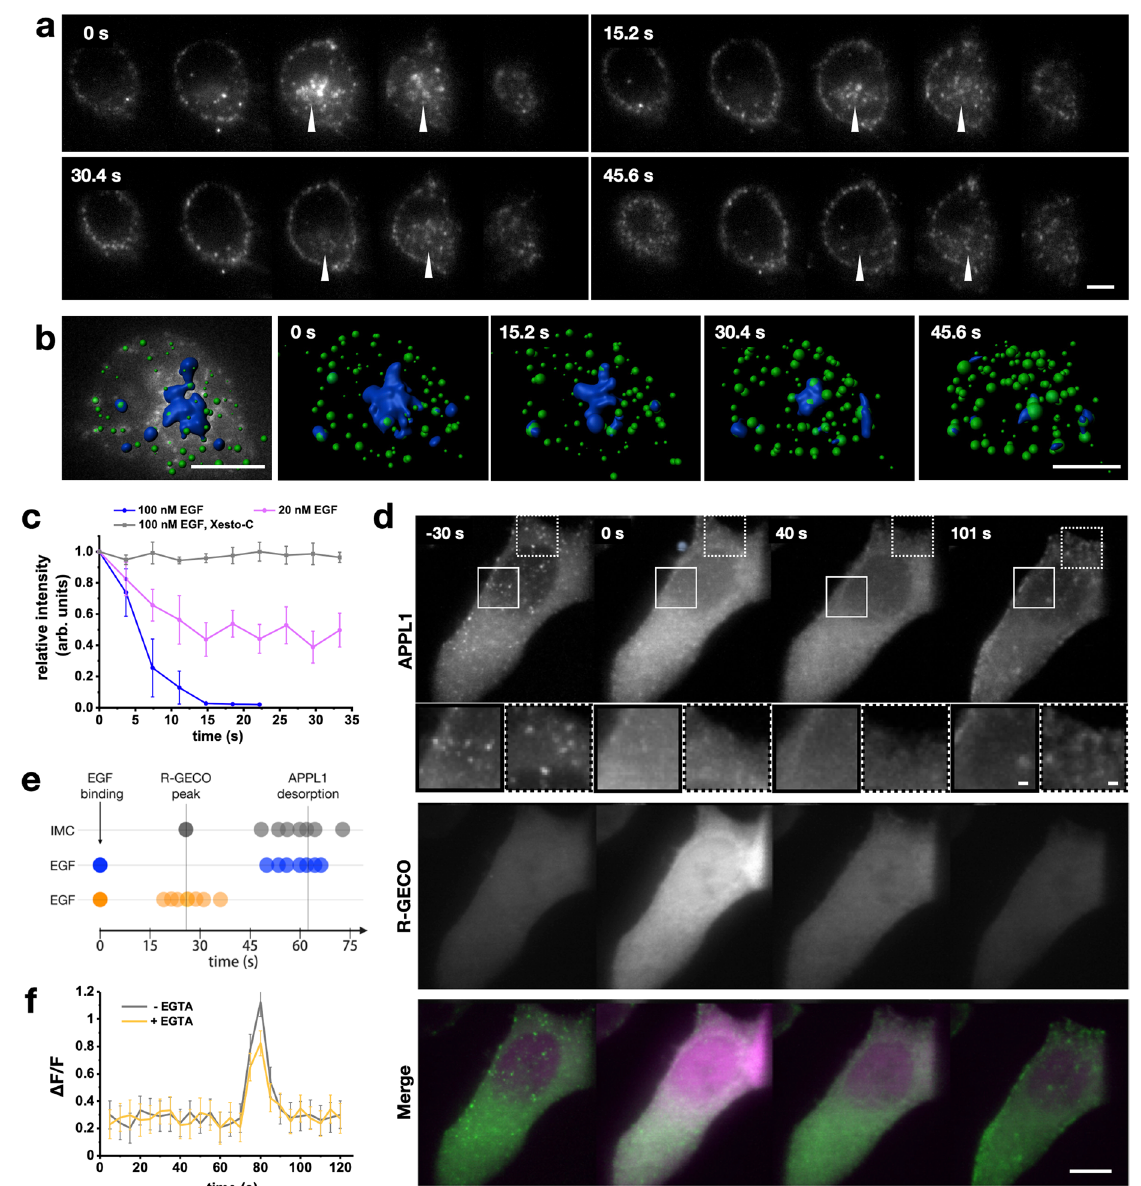
APPL1-EGFP following addition of 100 nM EGF. Scale bar = 4 µ m. b Example image depicting segmentation of APPL1 EGFP signal in the PNR using